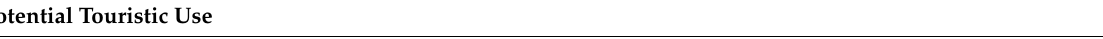
Table 2. Assessment of potential touristic use of the Jozef adit according to Brilha